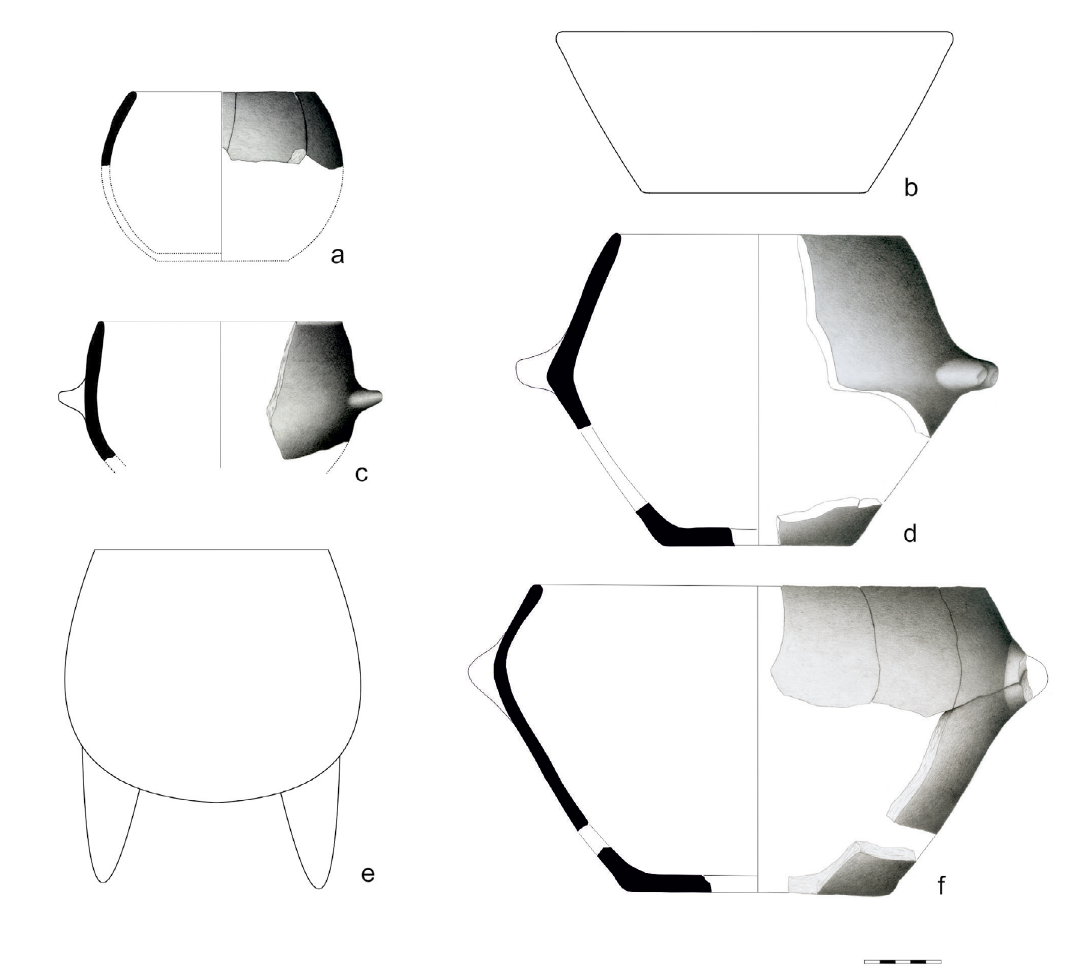
Figure 8. Different shapes and sizes of cooking pots from Stavroupoli: a) spherical vessel, b) conical vessel, c) hemispherical vessel, d and f) carinated vessels, e) tripod vessel (Urem-Kotsou